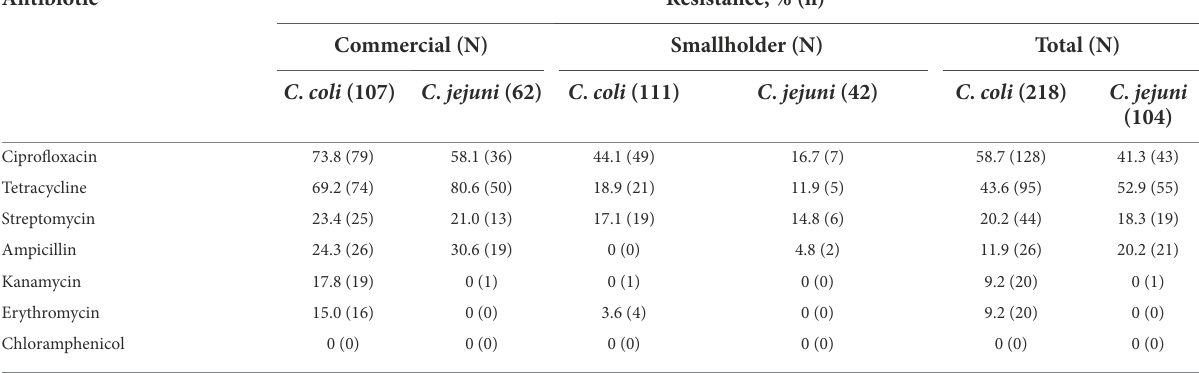
which no antibiotic resistance was detected, overall higher antibiotic resistance was observed for both C . coli and C . jejuni isolated from commercial farms compared to smallholder farms (Table 3). Campylobacter jejuni isolated from smallholder farms showed low resistance to ciprofloxacin (16.7%, n / N = 7/42), streptomycin (14.8%, n / N = 6/42), and tetracycline (11.9%, n / N = 5/42; Table 3). Compared to smallholder farms, animals from commercial farms were at least 50% more likely to be resistant to